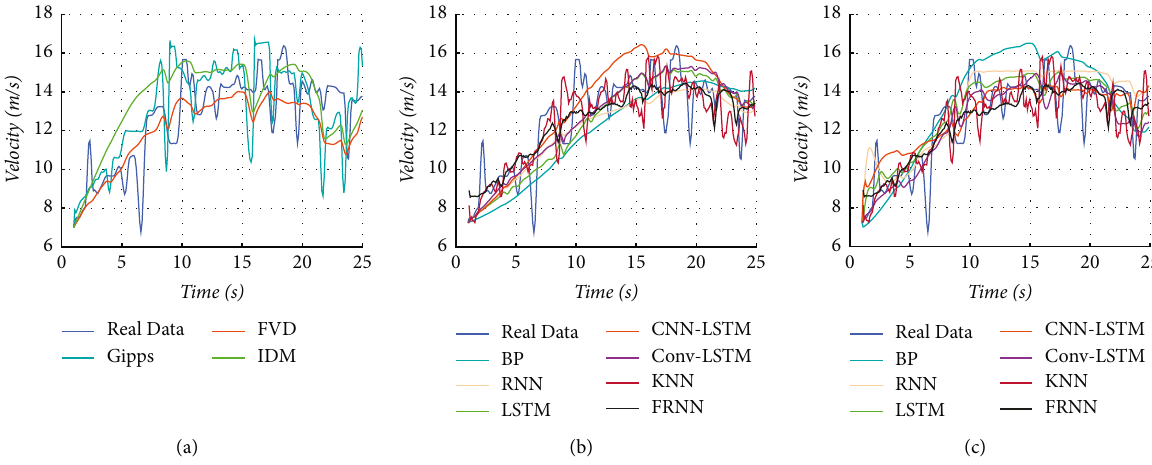
Figure 11: Velocity comparison of continuous traffic flow. (a) Conventional model. (b) ANN CF-A. (c) ANN CF-V